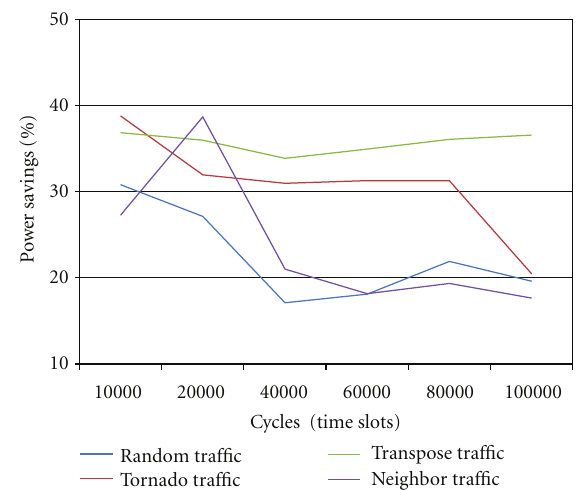
Figure 1: Power savings of a trivial threshold case compared to no on/o ff links